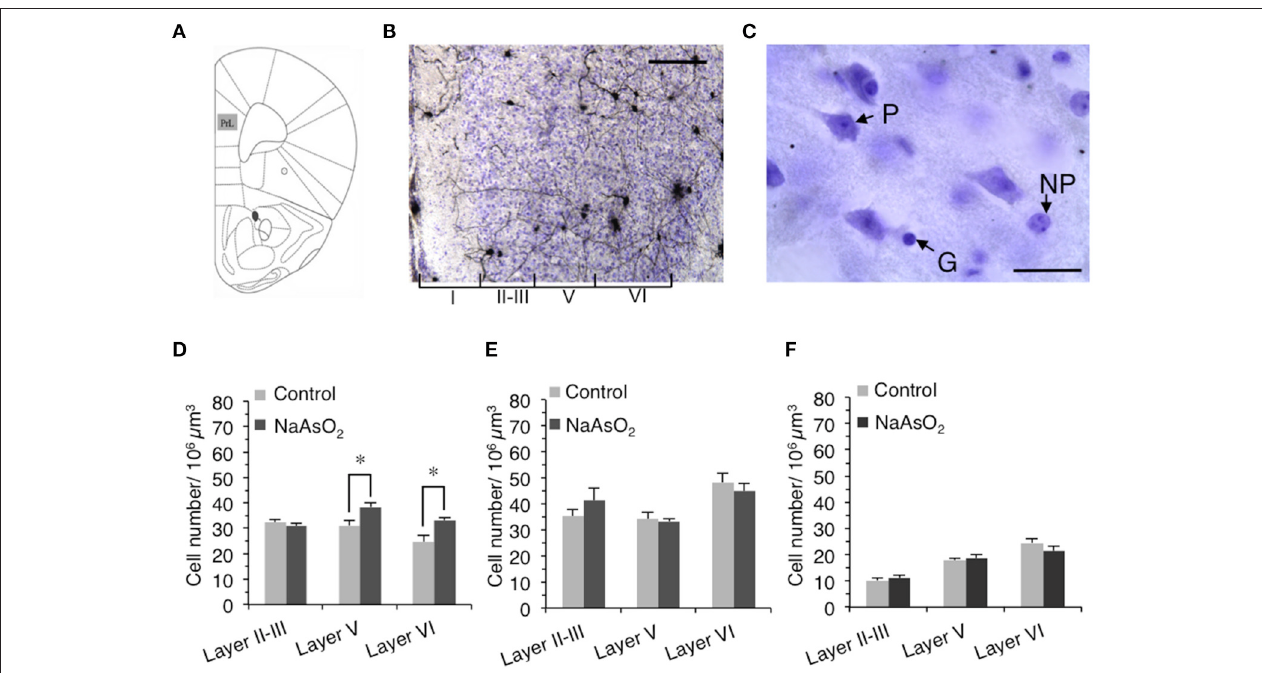
FIGURE 2 | Alteration in the number of neuronal cells in the PrL of adult female mice born to dams that were administered NaAsO 2 . (A) Illustration of the region of interest, the PrL, adapted from a mouse brain atlas ( Franklin and Paxinos, 2008). (B) Representative photomicrograph of the PrL in Golgi- and Cresyl Fast Violet-stained coronal brain sections. The Greek numbered (I–VI) regions indicate the cortical layers of the PrL. Scale bar = 20 µ m. (C) Photomicrographs of the PrL at high magnification showing a Cresyl Fast Violet-stained pyramidal neuron (P), a non-pyramidal neuron (NP), and a glial cell (G). The length of scale bar indicates 5 µ m. The number of pyramidal neurons (D) , non-pyramidal neurons (E) , and glial cells (F) in the PrL. Values are expressed as mean ± SEM (control group n = 7, NaAsO 2 -exposedgroups n = 5). An asterisk indicates p < 0.05 vs. the control